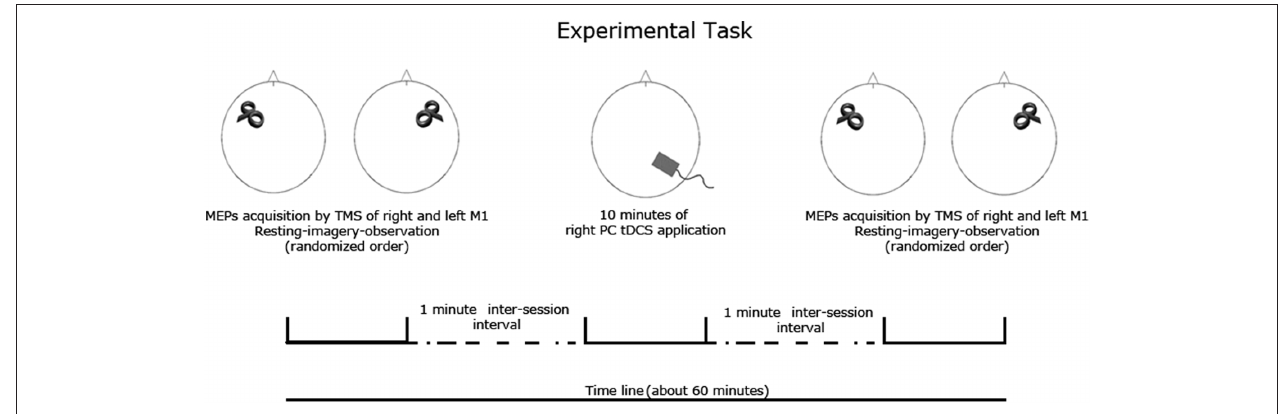
Figure 1 | experimental task. Subjects were submitted to a resting, motor imagery and an action observation task previously and after each tDCS session (anodal, cathodal, sham) spaced 5–7 days apart. Corticospinal excitability was measured by TMS of left and right primary motor cortex. The order of tDCS and task and TMS target (left and right M1) conditions was